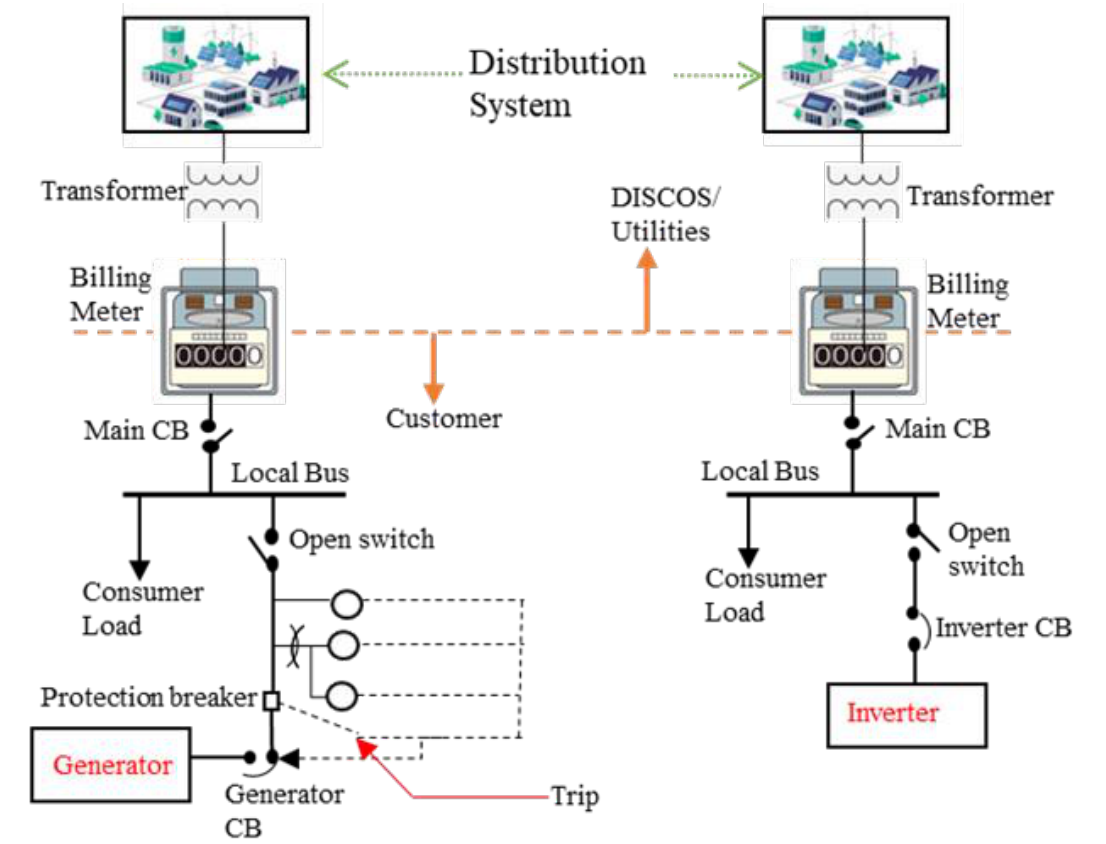
Figure 10. The Topology of distribution systems and Net Metering Concept draft [90].